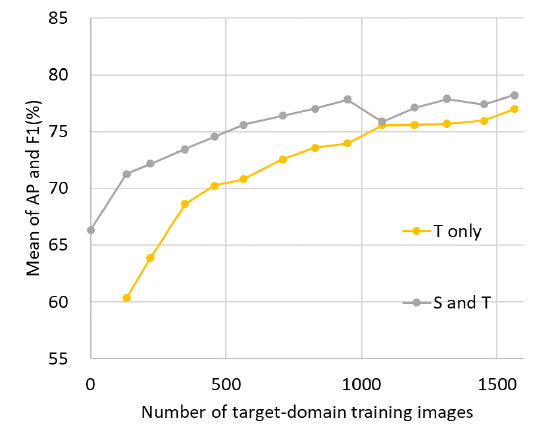
Figure 7. Detection accuracy improvement in each condition by increment of labeled training data of the target domain. S and T represent the source and target domains, respectively.